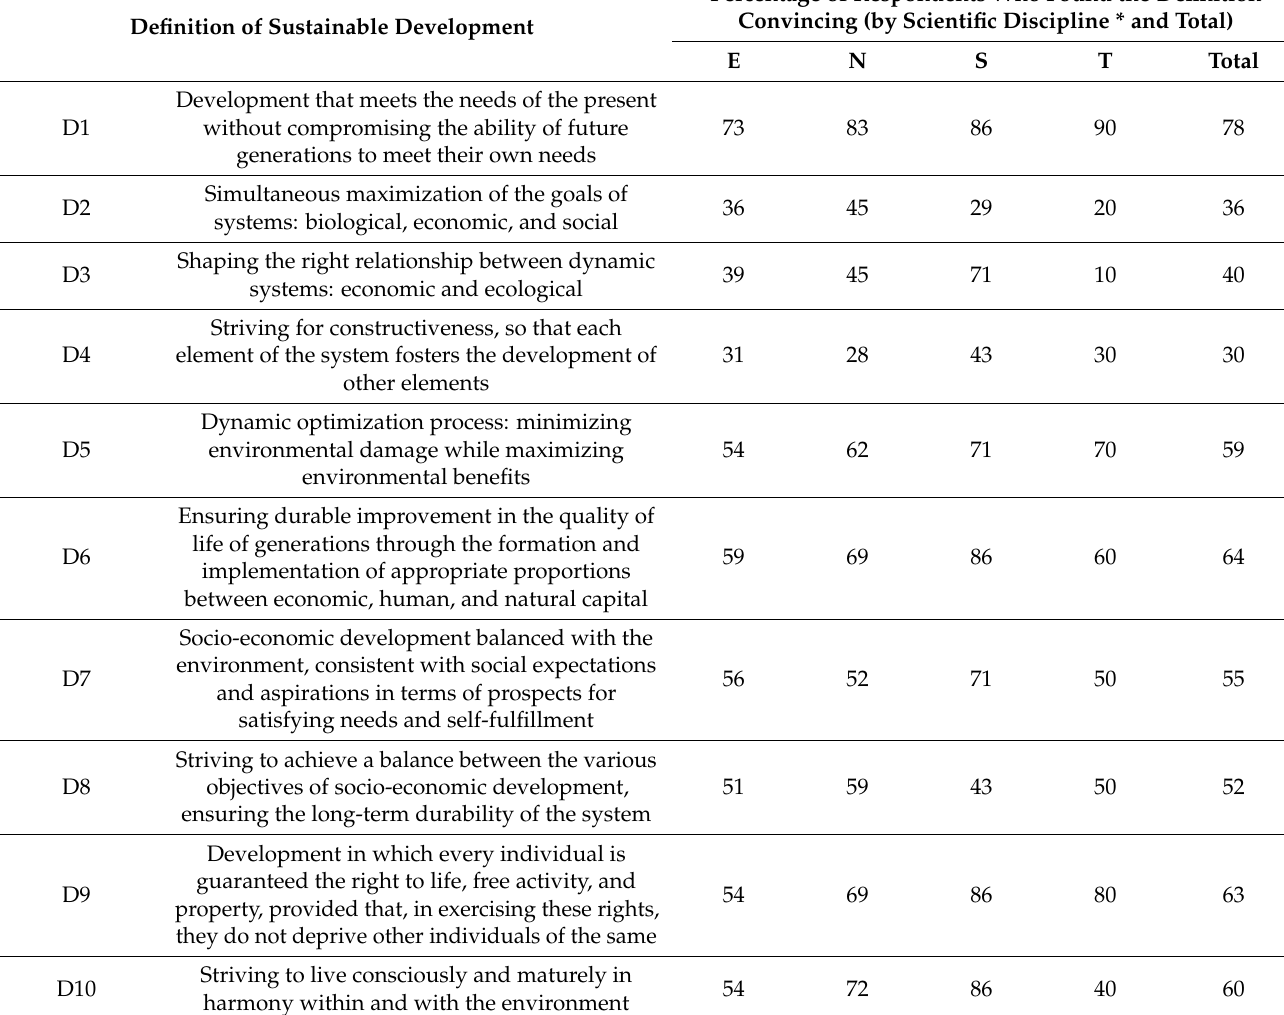
Table 2. Evaluation of selected definitions of SD in terms of the best possible explanation of the essence of the idea of sustainable development to society (i.e., so that every citizen can realize the idea of SD in everyday life). Percentage of Respondents Who Found the Definition Definition of Sustainable Development